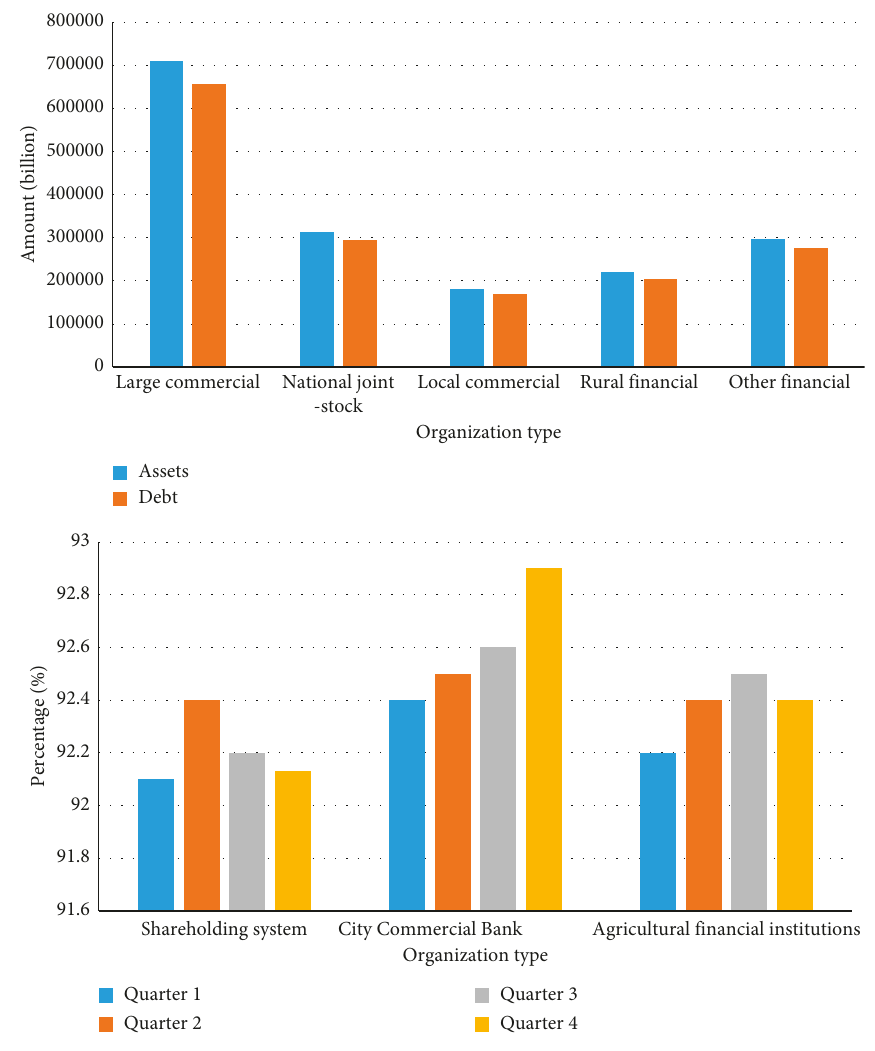
Figure 5: Comparison of debt ratio of small and medium